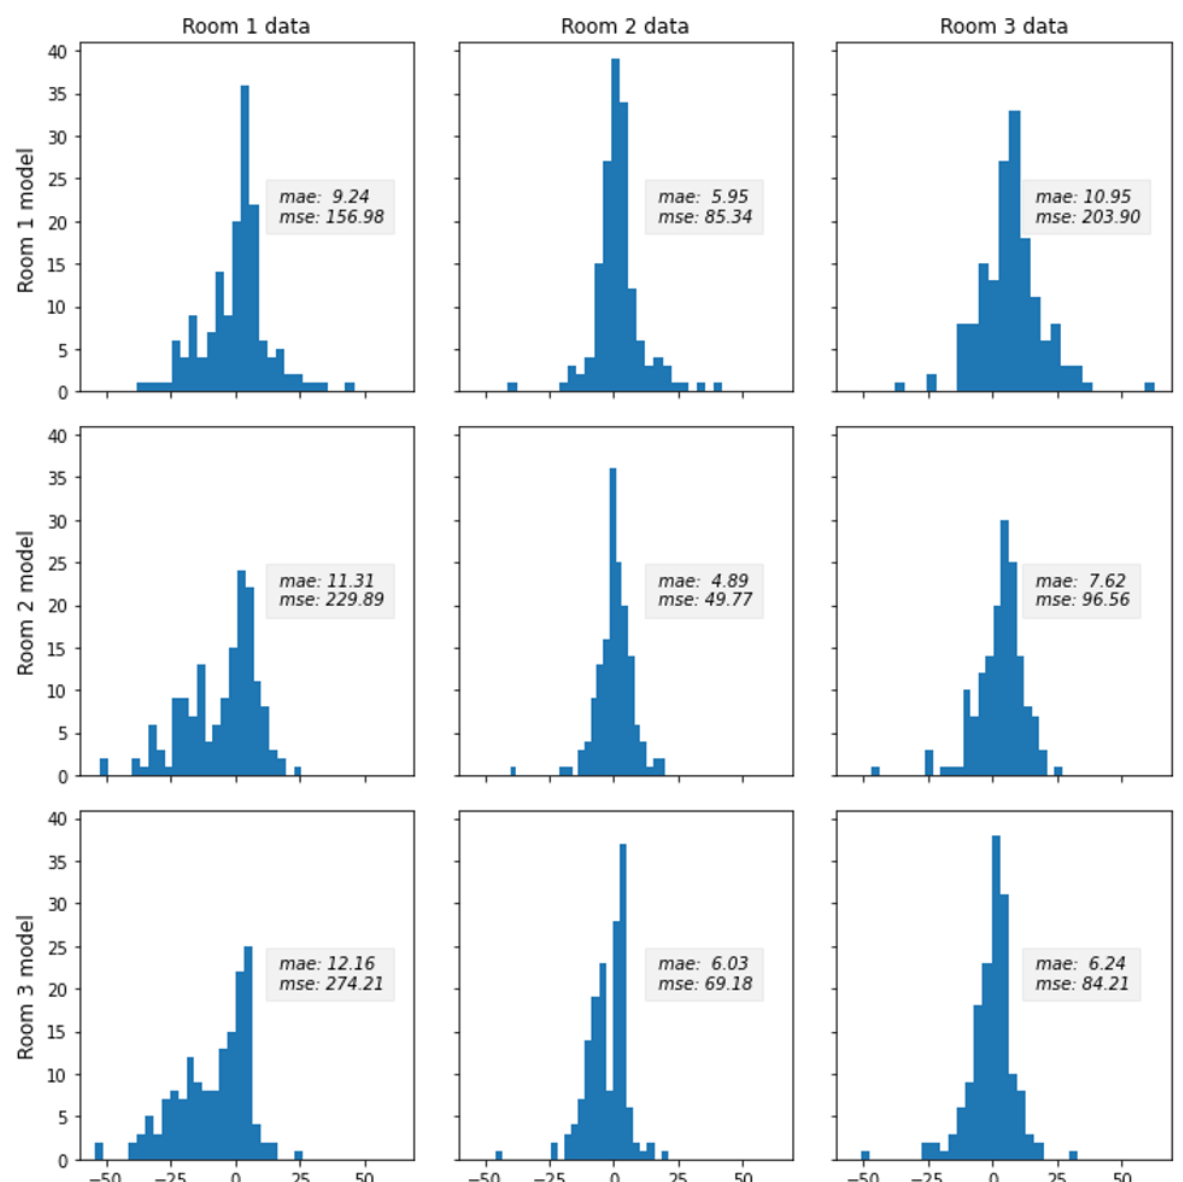
Figure 7. Predicting space occupancy by self-trained model vs. transferred models. The histogram plot in each cell shows the distribution of errors for the occupancy counting